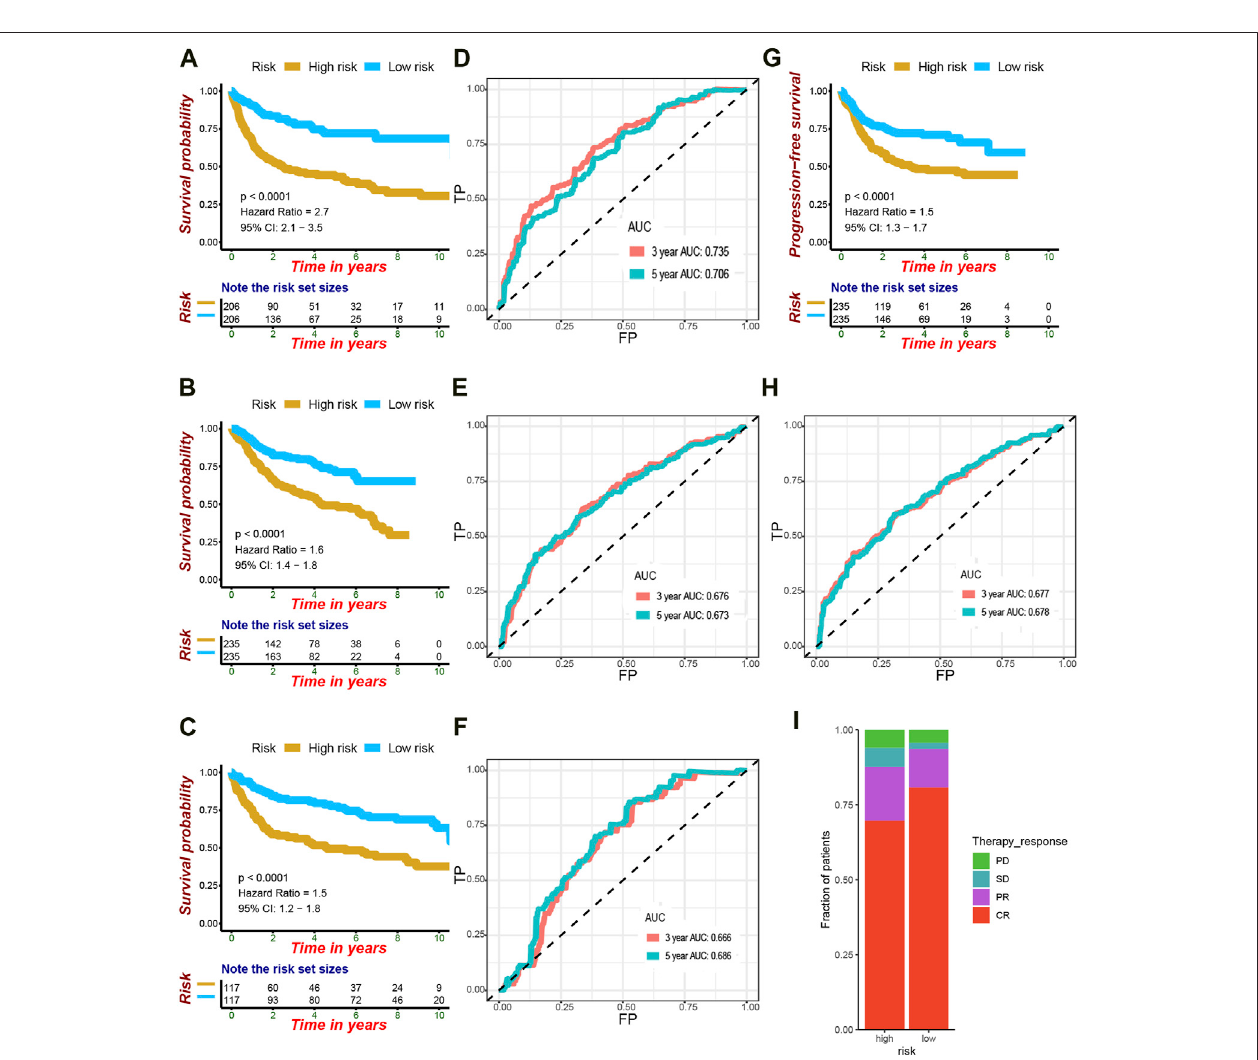
FIGURE4| Veri fi cationoftheef fi cacyandaccuracyofthegenesignature. (A) Kaplan – MeieranalysisofOSforlow-riskandhigh-riskpatients inthetrainingcohort. (B) Kaplan – Meier analysis of OS for low-risk and high-risk patients in the GSE31312 cohort. (C) Kaplan – Meier analysis of OS for low-risk and high-risk patients in the NCICCR cohort. (D) Area under the ROC curve at 3 and 5 years to evaluate the accuracy of OS prediction in the training cohort. (E) Area under the ROC curve at 3 and 5 yearstoevaluatetheaccuracyofOSpredictionintheGSE31312cohort. (F) AreaundertheROCcurveat3and5 yearstoevaluatetheaccuracyofOSprediction intheNCICCR cohort. (G) Kaplan – Meiercurves showingprogression-free survivalofhigh-riskand low-riskpatientsbasedontheGSE31312 cohort. (H) Areaunderthe ROC curve at 3 and 5 years to evaluate the accuracy of PFS prediction in the GSE31312 cohort. (I) Difference in the therapy response between high-risk and low-risk patients in the GSE31312